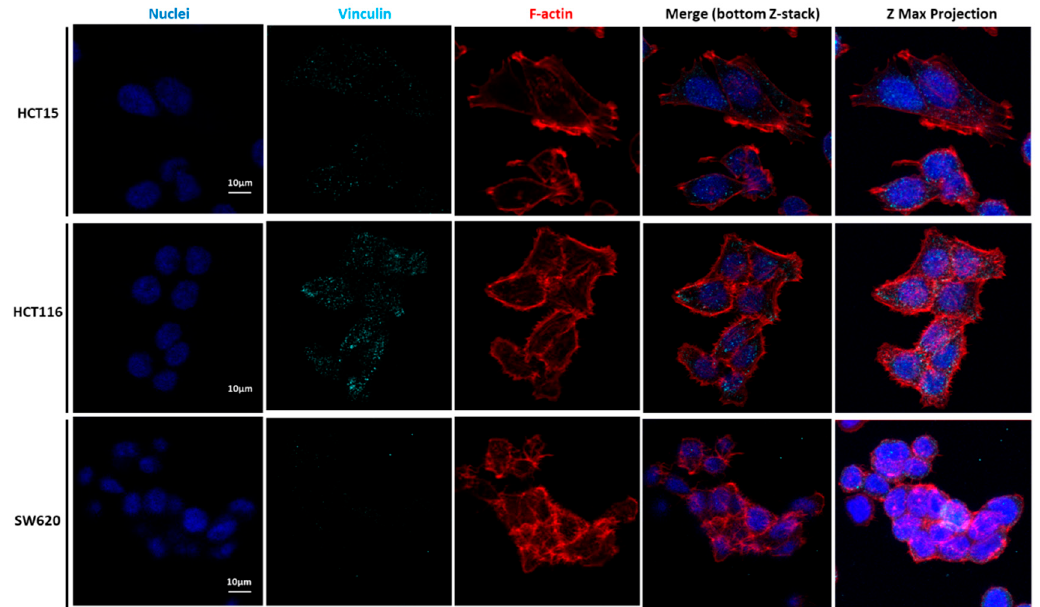
Figure 7. Vinculin expression in CRC cell lines HCT15 ( top ), HCT116 ( middle ), and SW620 ( lower images ) immunostained for DAPI to illustrate the nuclei (blue), vinculin (cyan), and phalloidin for F-actin filaments (red). The bottom Z-stack micrograph is shown, and a Z-maximum projection showing the overall stains is also represented ( right panels ). Scale bars: 10 µm.